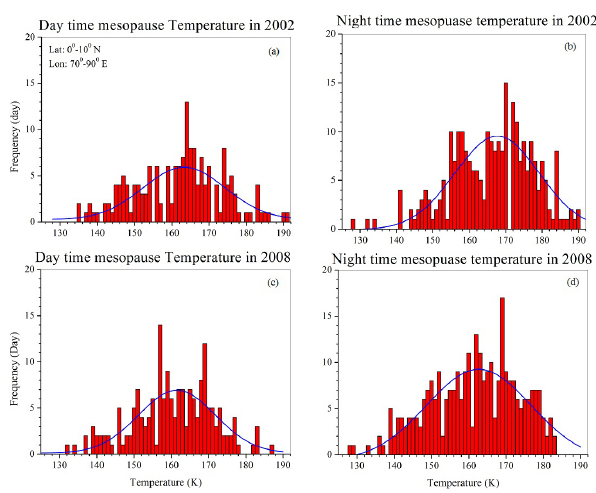
Figure 7. The mesopause temperature distribution for the year 2002/2008 (high/low solar activity) for daytime (a, c) and night- time (b, d) measurements. Red bars show the mesopause tempera- ture occurrences while the blue curves are the best fitted Gaussian